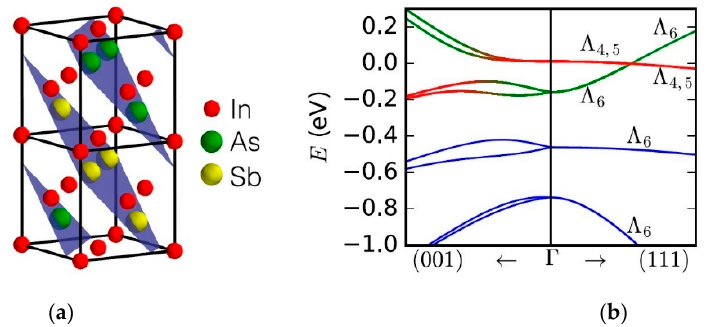
Figure 3. CuPt-ordered InAs 0.50 Sb 0.50 : ( a ) crystal structure with the alternating Sb-As (111) planes highlighted, ( b ) empirical tight binding band structure calculation around Γ for | k | ≤ 0.1 Å − 1 (after [40]).